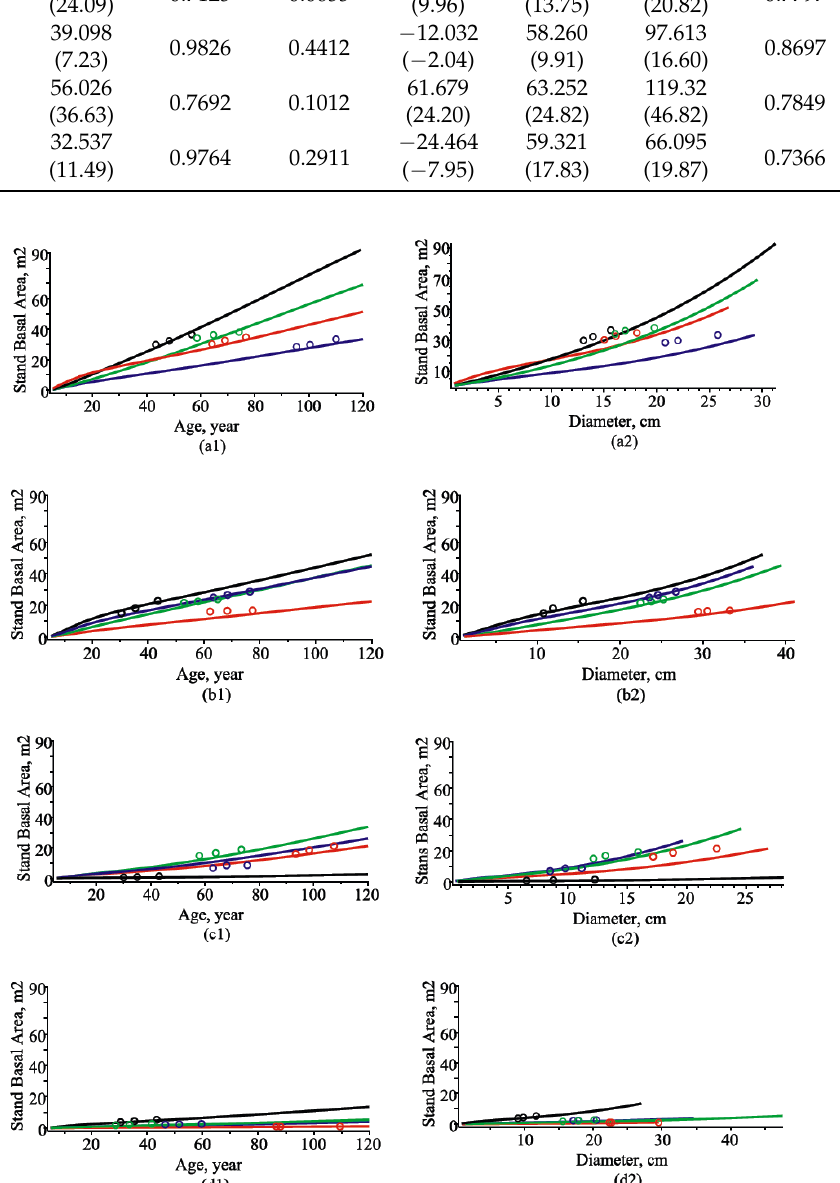
Figure 6. Kinetics of the stand basal area for four randomly selected stands from a validation dataset: ( left panel ) against the age; ( right panel ) against the diameter predictions; ( a1 , a2 ) all species; ( b1 , b2 ) pine ( Pinus sylvestris ), k pine = 0.73, 0.18, 0.73, 0.25 ( black, red, blue, and green ) , respectively; ( c1 , c2 ) spruce ( Picea abies) k spruce = 0.05, 0.80, 0.68, 0.74 ( black, red, blue, and green ) , respectively; ( d1 , d2 ) silver birch ( Betula pendula Roth and Betula pubescens Ehrh.) k birch = 0.22, 0.02, 0.04, 0.07 ( black, red, blue, and green ) , respectively; black—first stand; red—second stand; blue—third stand; green—fourth stand; and circles—observed